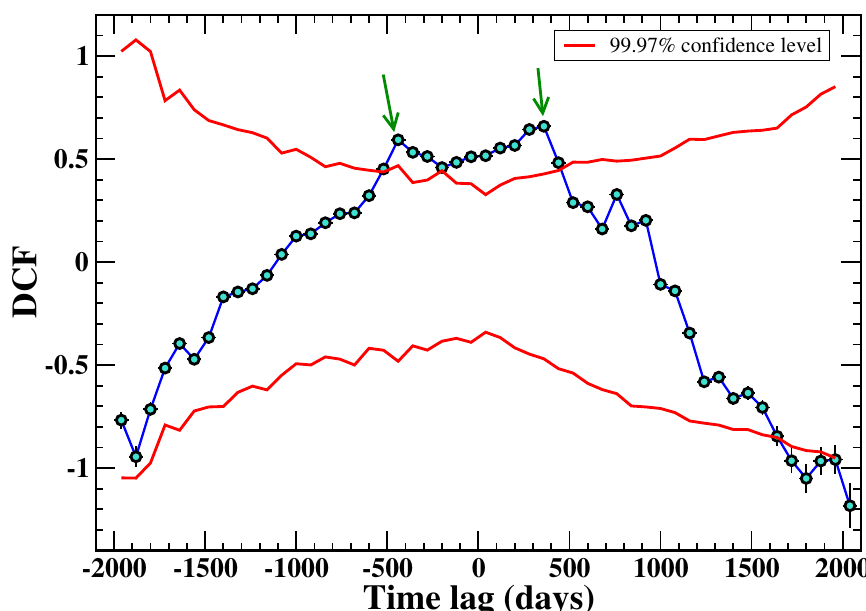
Figure 7. Cross-correlation analysis curve of the γ -ray and radio flux variations observed in 3C 84 (see Figure 5). The two peaks at 500 and + 400 days (green arrows) imply γ -rays flux variations leading − and lagging those at radio. A detailed analysis suggests the presence of multiple γ -ray emitting sites in the source